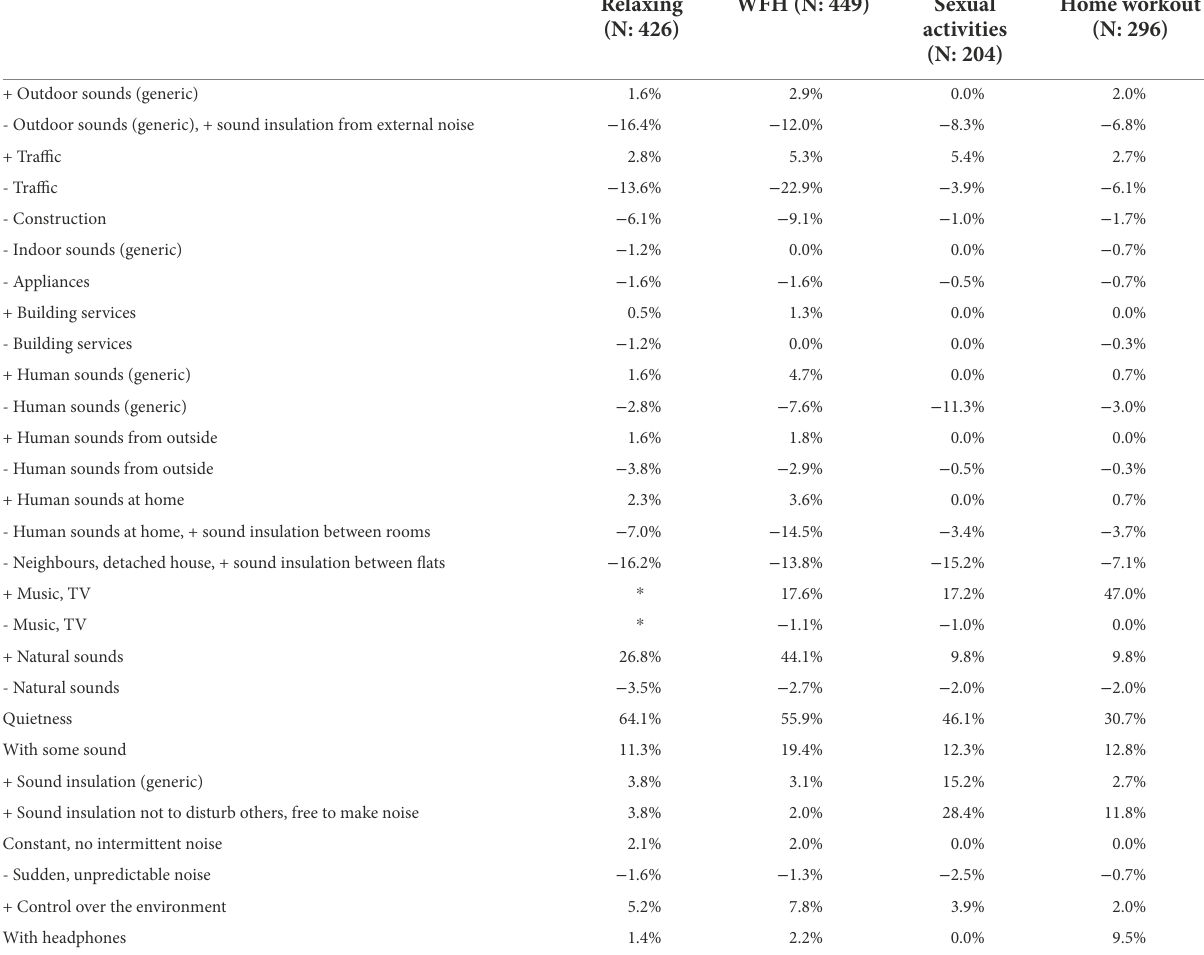
TABLE 6 Percentage of respondents who reported the willingness of presence, increase (+), or decrease ( − ) of a certain feature in the ideal soundscape for the different activities